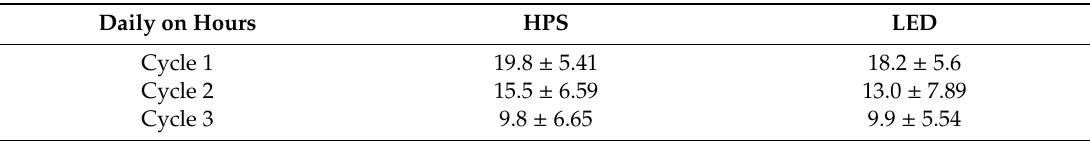
Table 1. Mean ± standard deviation of number of hours each lighting array was on each day during phase 1, broken down by harvest cycle.